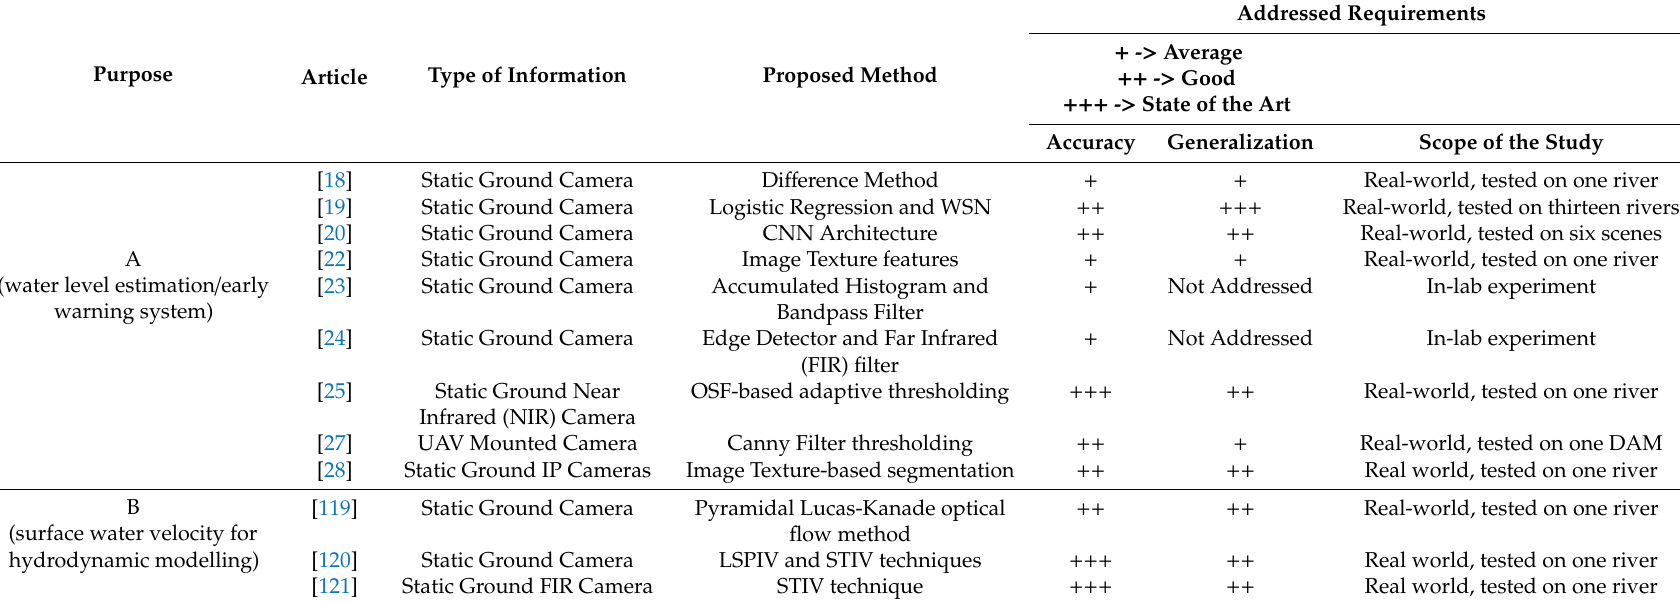
Table 7. Analysis of computer vision applications against addressed requirements: Part